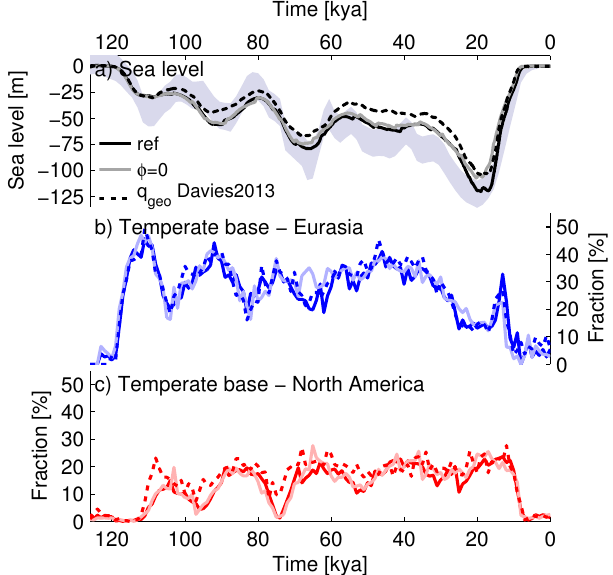
Figure 8. Evolution of (a) sea level and ice sheet temperate base area fraction over Eurasia (b) and North America (c) over the last glacial cycle. In all panels three model simulations are shown: the reference run (dark solid lines), the simulation with zero poros- ity representing the no permafrost case (light solid lines) and the model run with the geothermal heat flux from Davies (2013) (dotted lines). The modeled sea level is given by the modeled NH ice vol- ume equivalent amplified by an additional 10% to roughly account for variations in Antarctic ice volume. The same approach was used in Ganopolski and Calov (2011) and is based on the estimates of Antarctic ice volume variations from Huybrechts (2002). The blue shading in (a) represents the sea level range from the reconstruction of Waelbroeck et al. (2002).